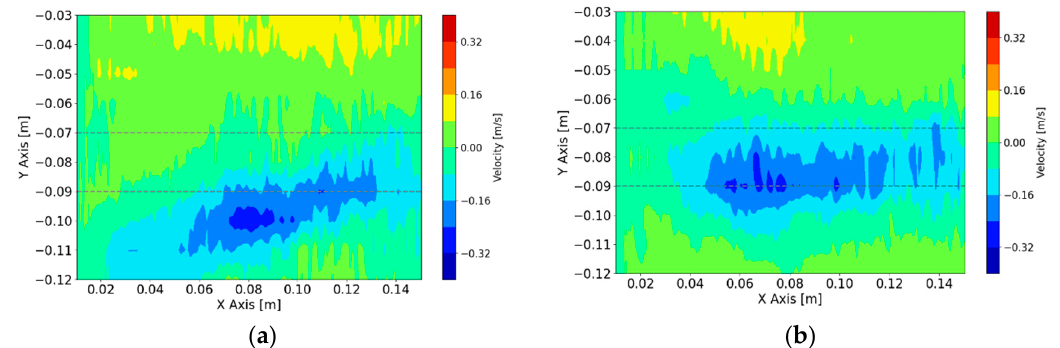
Figure 7. Reconstruction of velocity profile with identified shallow region to quantify jet impingement ( a ) t = 300 s, ( b ) t = 800